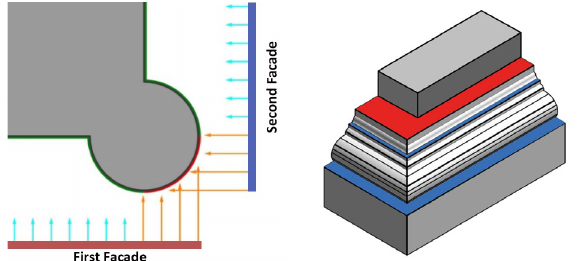
Figure 7 (On the left) the issue of double projection on the curve surface of the column along the corner. (On the right) the horizontal elements of the object with part of their area which which is calculated incorrectly because it is in contact with other